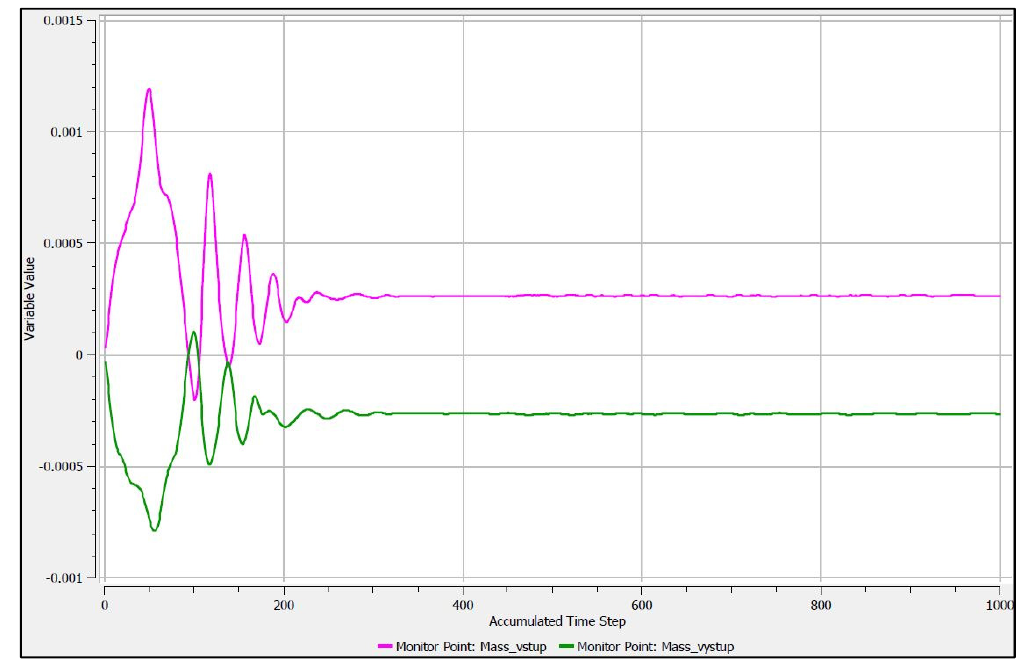
Figure 8. Mass flow convergence.